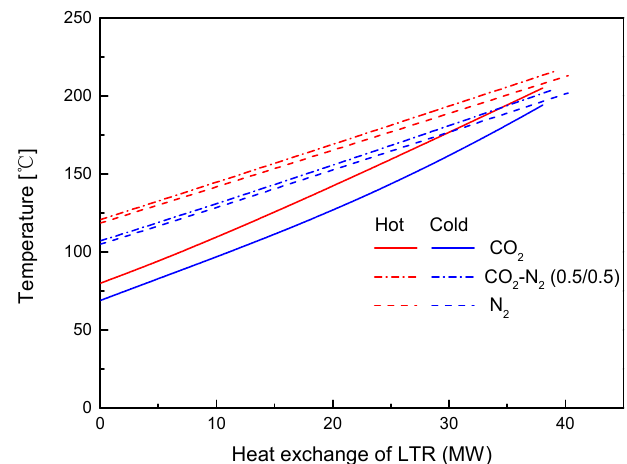
Figure 17. Temperature distributions of CO 2 - N 2 in LTR.